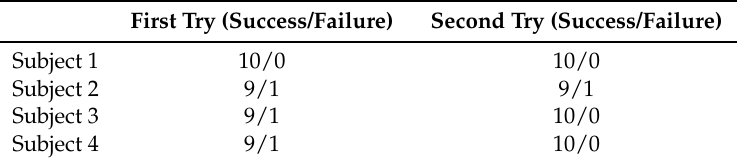
Table 2. Results of the first walking test.